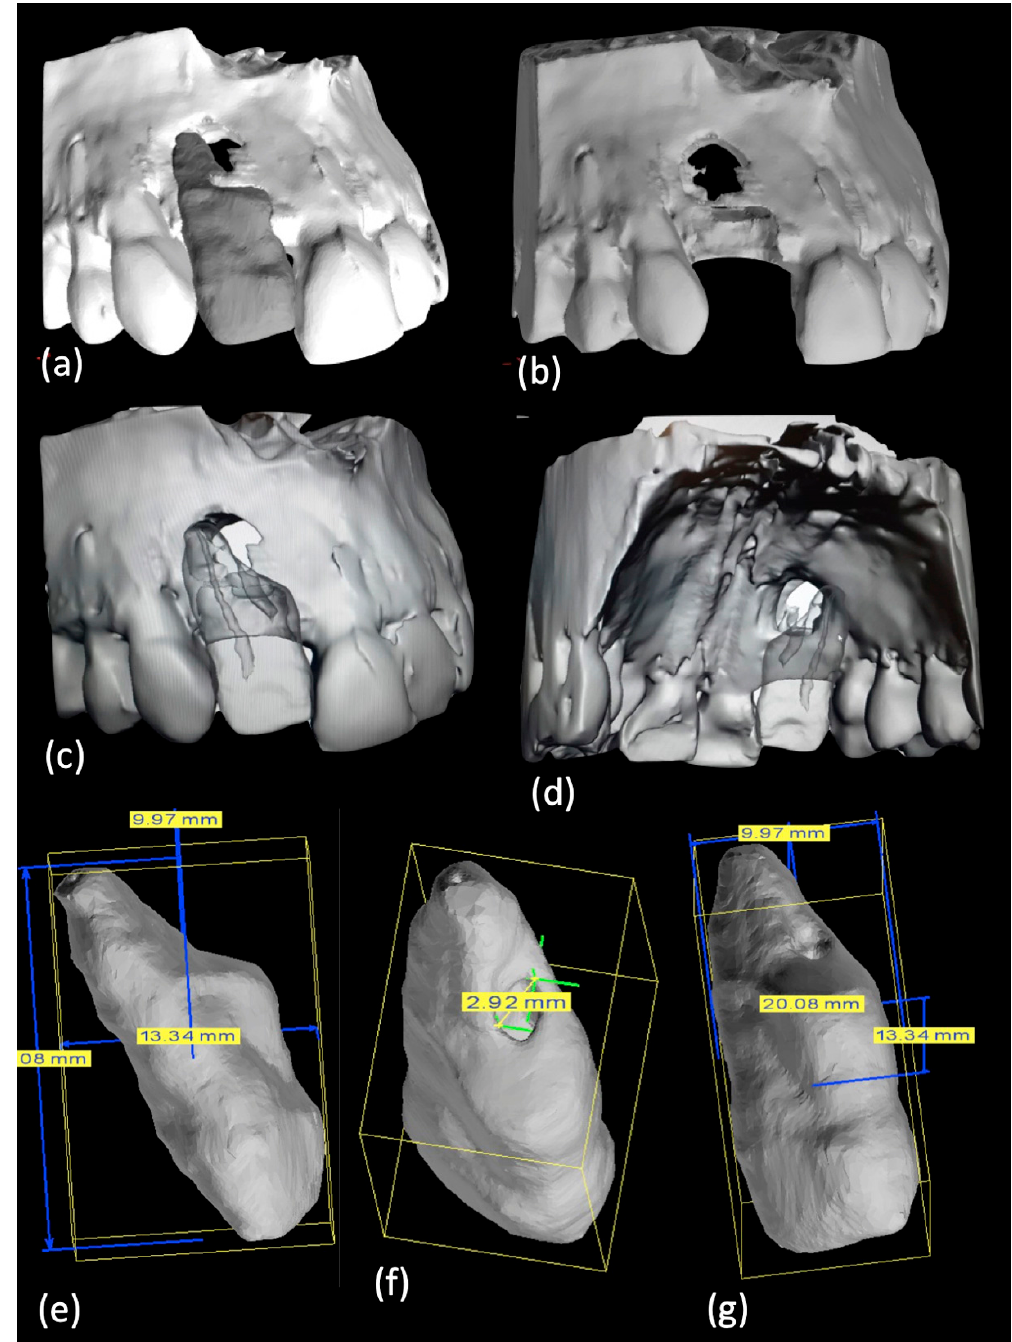
Figure 2. ( a – d ) An STL of bone structure with and without element 1.2 was produced and ( e – g ) dimensions of element 1.2 were achieved.